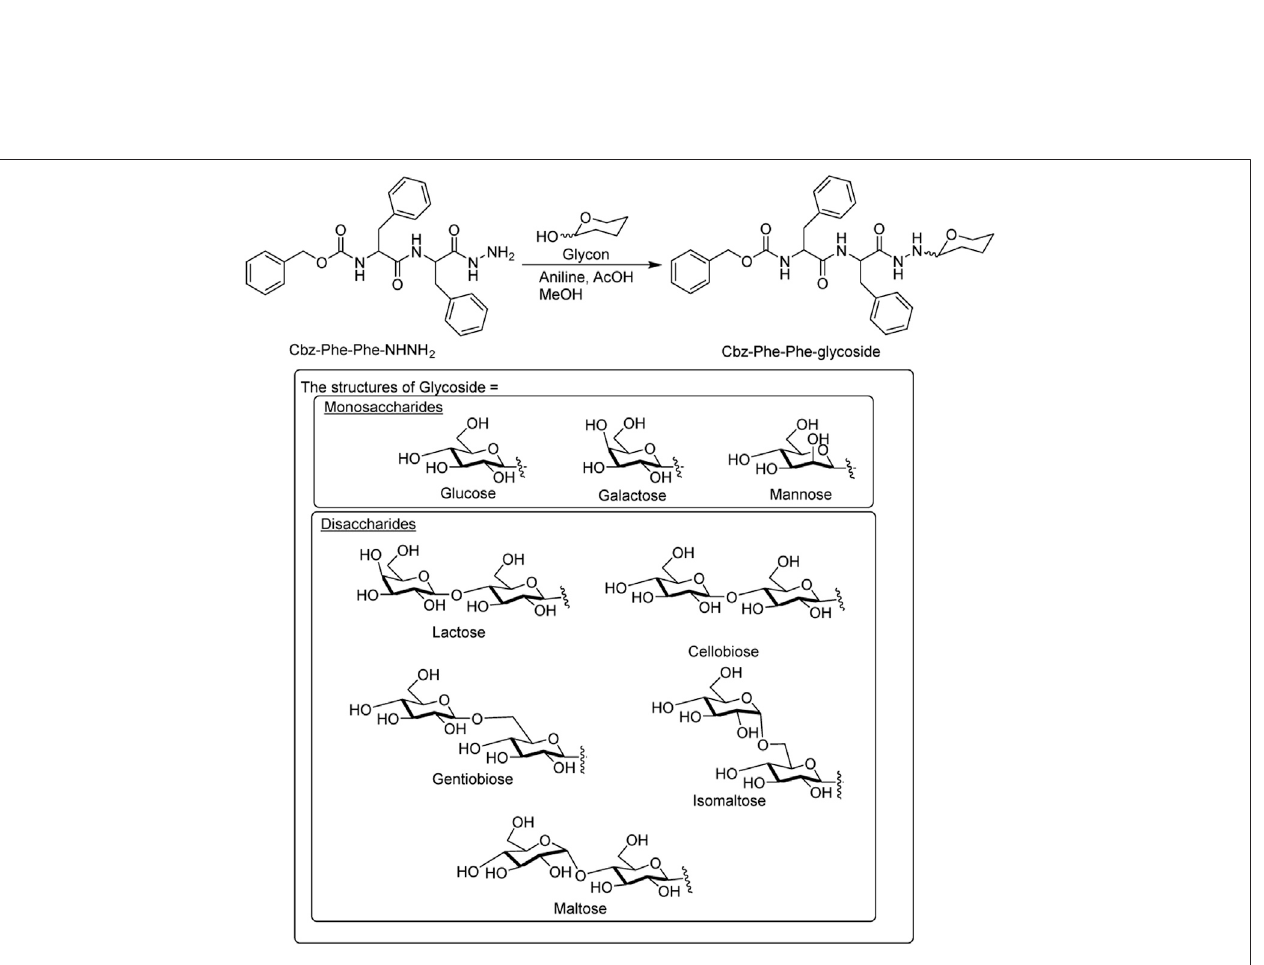
Frontiers in Chemistry |